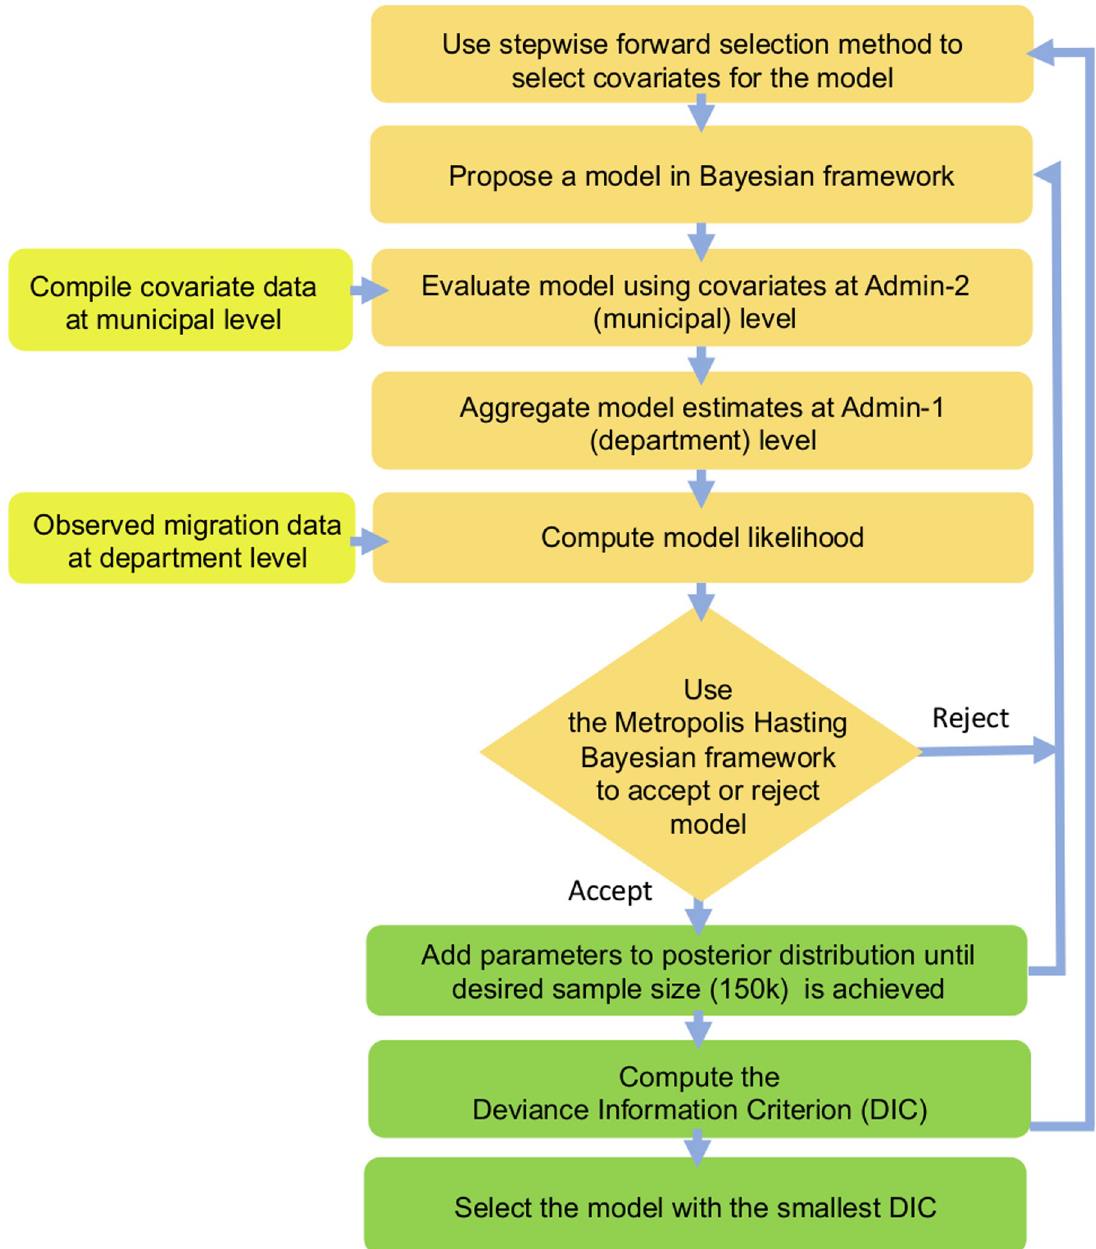
Fig 1. Flowchart of the Bayesian model selection process under the fine-scale model approach. The input stages are shown in yellow, and the processing stages are shown in orange, while the output stages are in